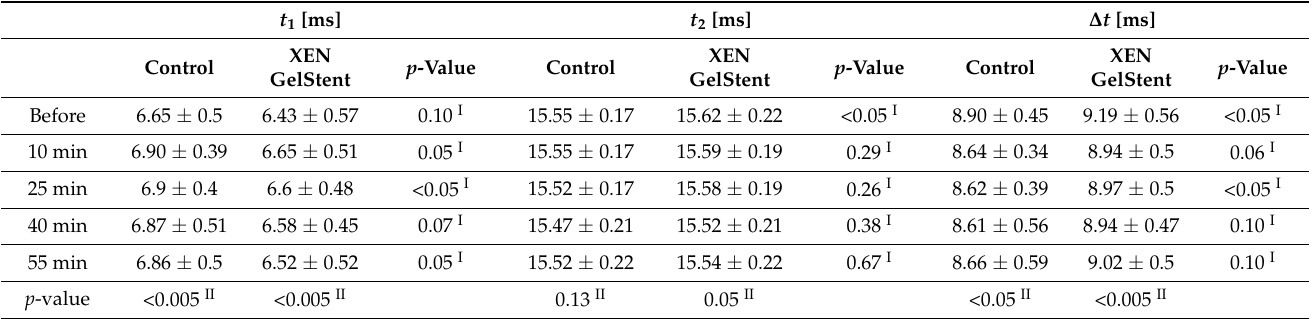
Table 5. The time of the first and second applanation (respectively t 1 and t 2 ) along with the in- terspace between applanations ( ∆ t ) during the water drinking test (WDT) in the control and XEN GelStent